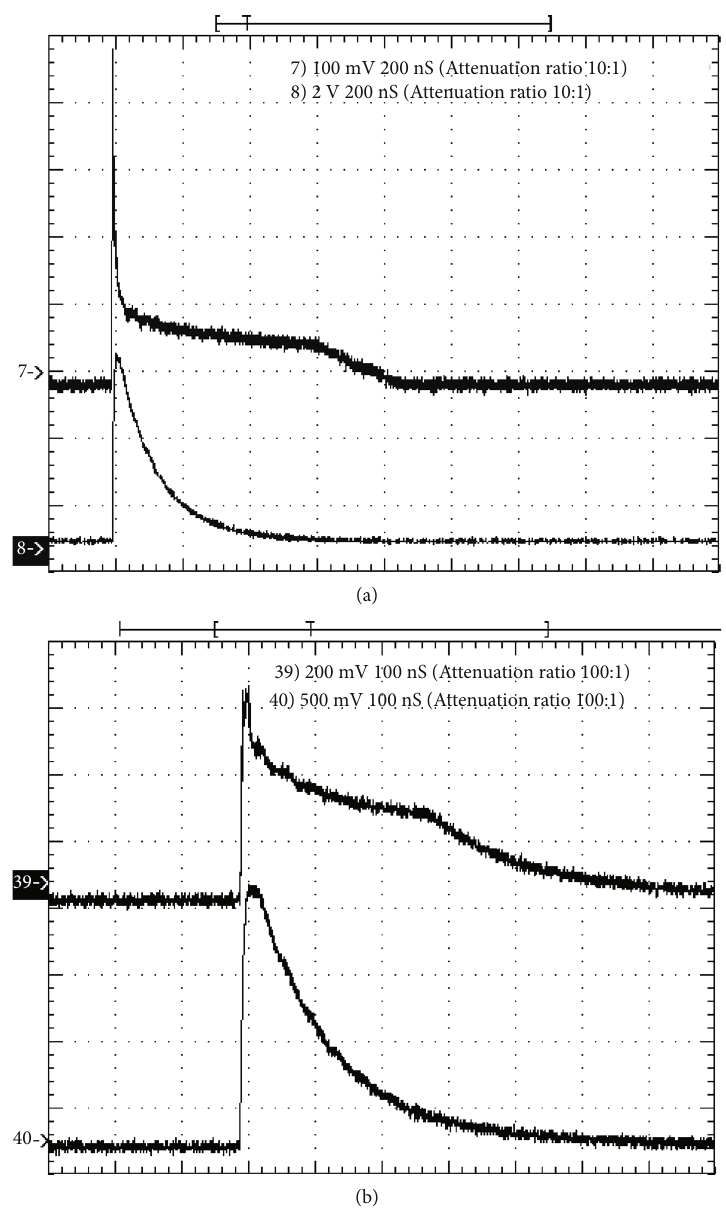
Figure 11: Response waveform of Zener diode to narrow